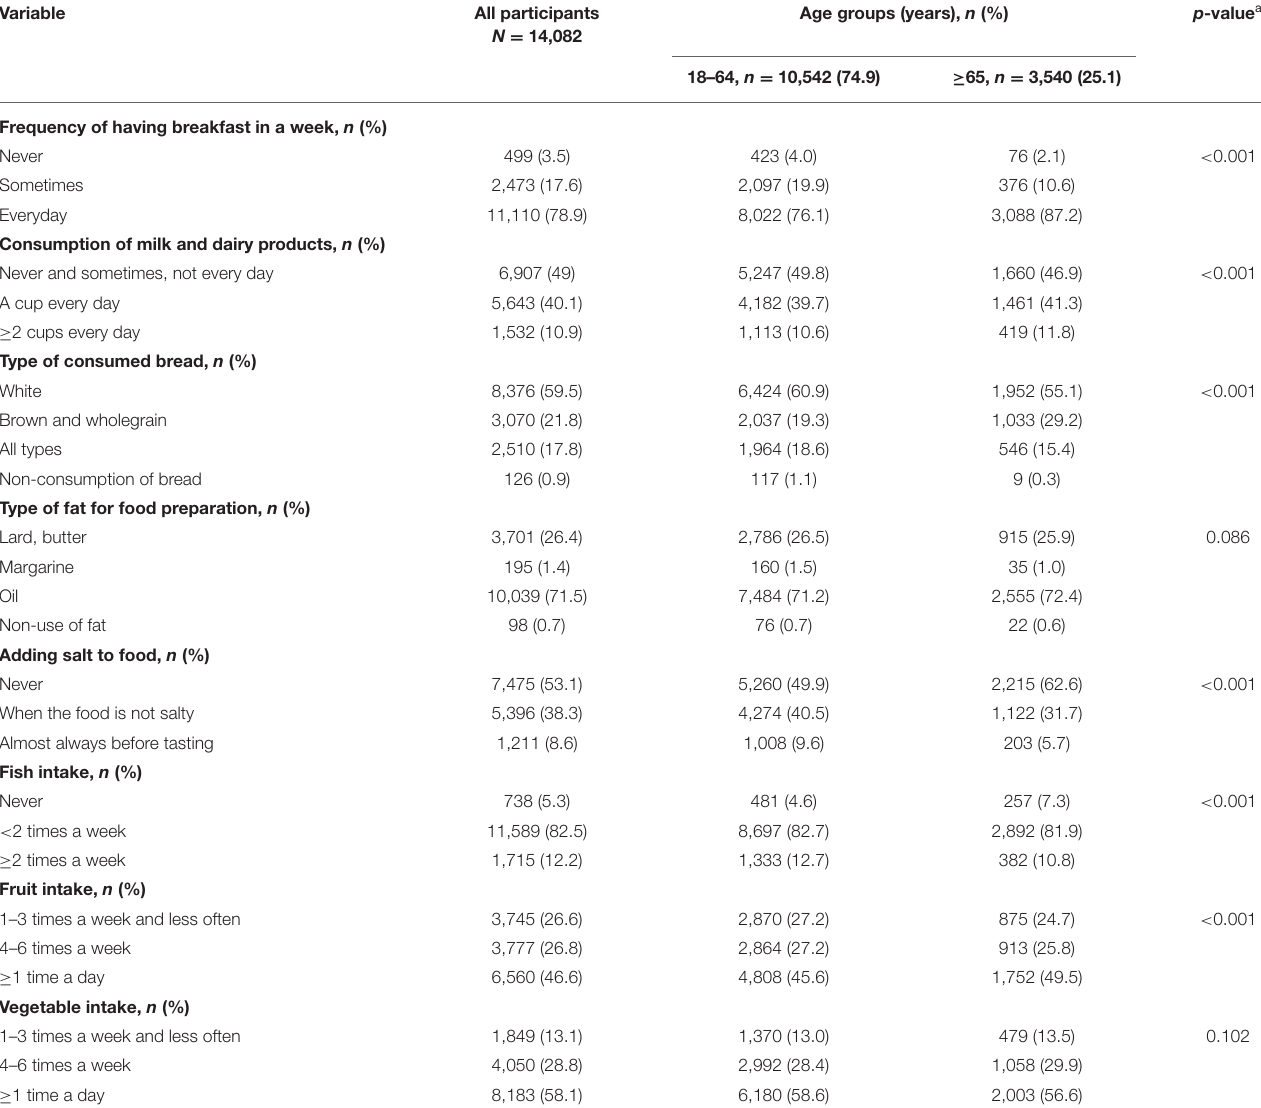
TABLE 2 | Dietary habits of the study participants by age groups. Variable All participants